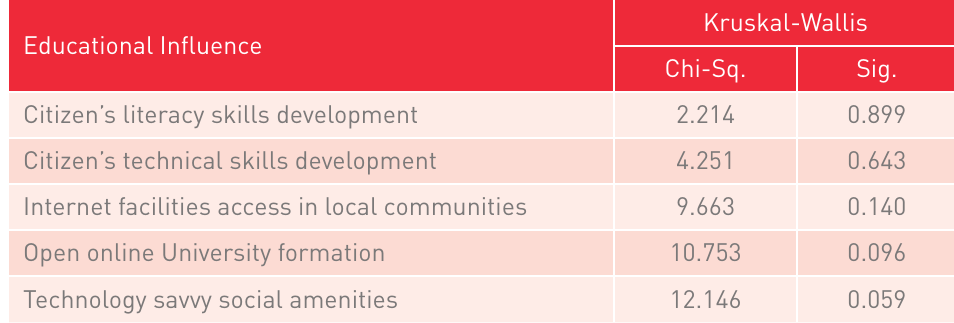
Kruskal-Wallis H-Test for Influence of Education on Resilience Educational